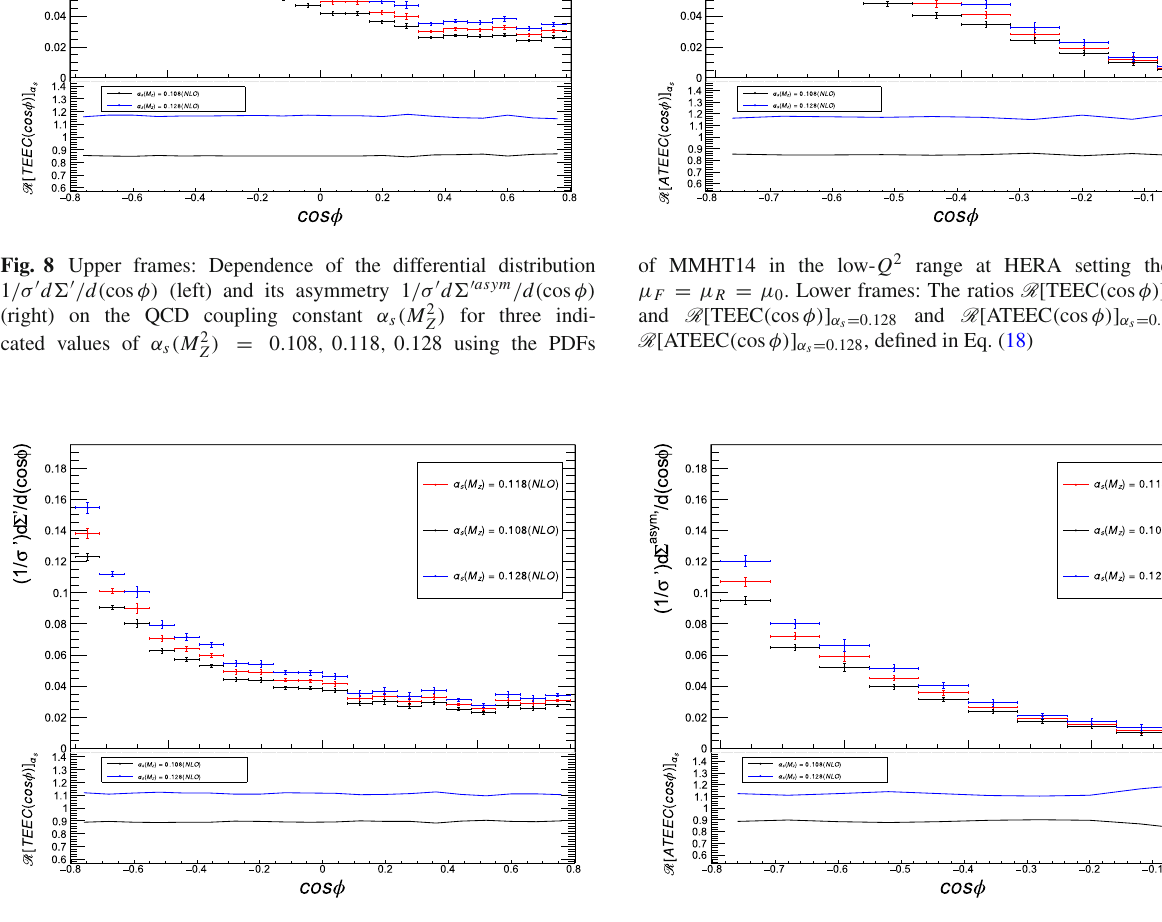
Fig. 9 Dependence of the differential distribution 1 /σ (cid:7) d (cid:9) (cid:7) / d ( cos φ) (left) and its asymmetry 1 /σ (cid:7) d (cid:9) (cid:7) asym / d ( cos φ) (right) on the QCD coupling ) as in Fig. 8, but for the high- Q 2 range at HERA constant α s ( M 2 Z x ∈ [ 0 . 5 , 2 ]